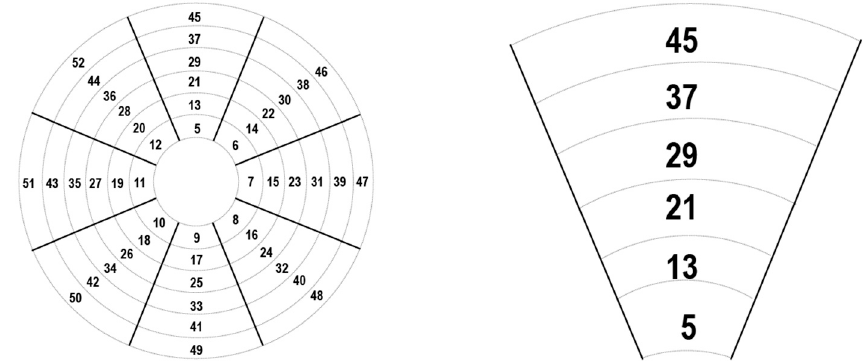
Figure 3. All antenna sectors ( left ) and a single antenna sector ( right ).